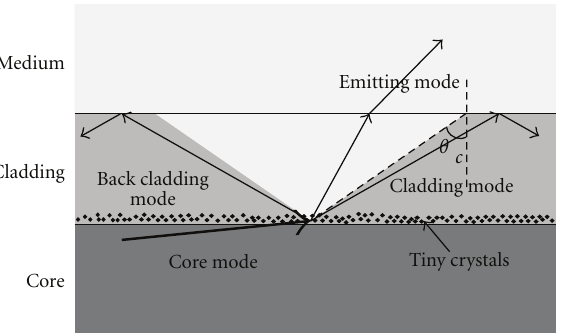
Figure 2: Light scattering in the cladding of